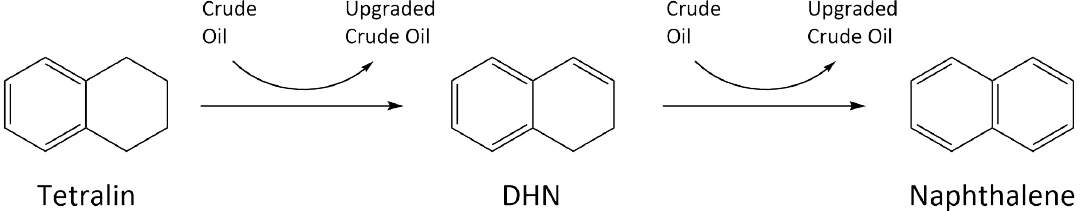
Figure 38. Two-step model for the transfer of hydrogen from tetralin to heavy oil. Figure adapted from Ref. [168]. DHN: